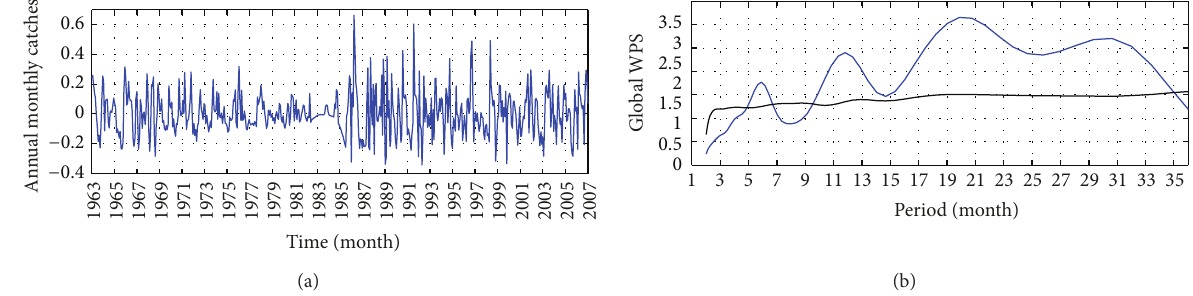
Figure 3: (a) Annual component ( 𝑥 𝑎 ) from 4 -level SWT and (b) GWPS.